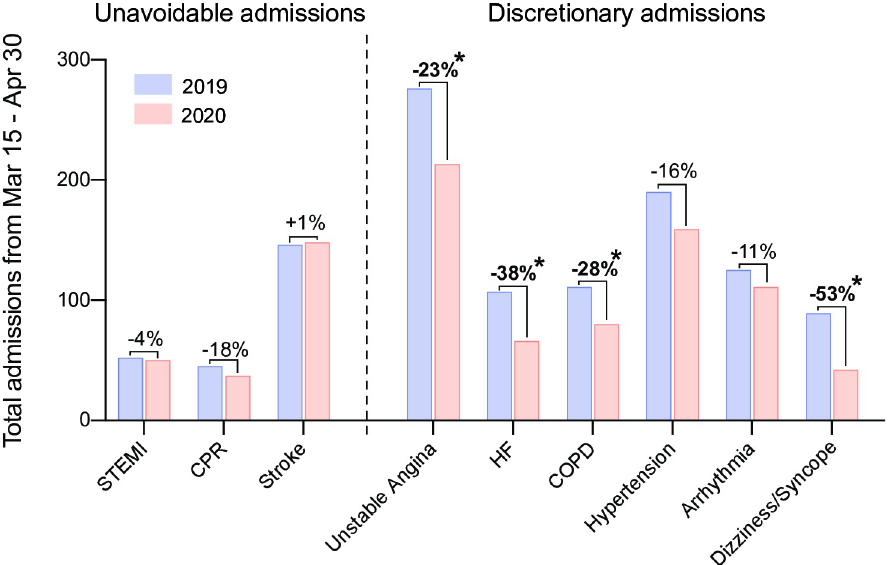
Fig 2. Analysis of total admissions according to diagnoses during the lock-down period. Numbers were collected from March 15 to April 30 from 2019 and 2020. Bold label and asterisk indicate a significant difference between 2020 and 2019 in the Poisson Model. (2020 vs. 2019 for unstable angina p = 0.004, HF p = 0.002, COPD p = 0.033, dizziness/ syncope p < 0.001). STEMI, ST-elevation myocardial infarction; CPR, cardiopulmonary resuscitation; HF, decompensated heart failure; COPD, exacerbated chronic obstructive pulmonary disease.